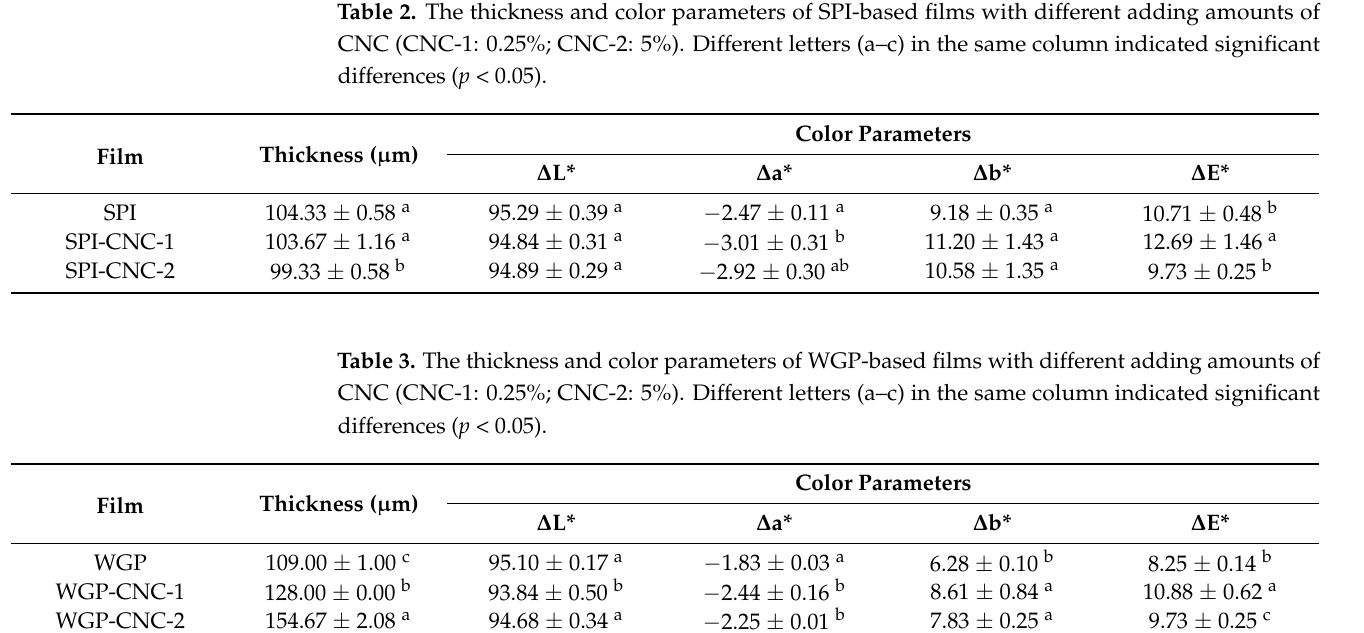
Table 2. The thickness and color parameters of SPI-based films with different adding amounts of